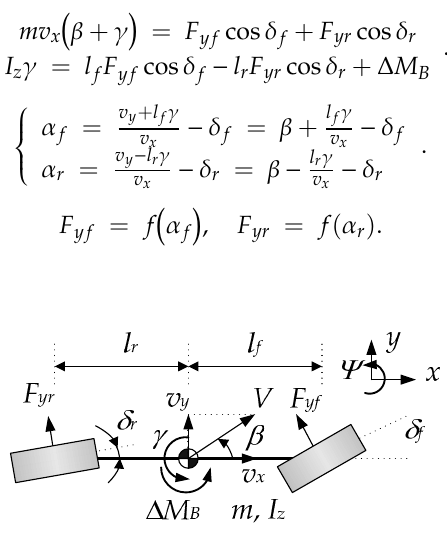
Figure 1. 2-DOF bicycle model.